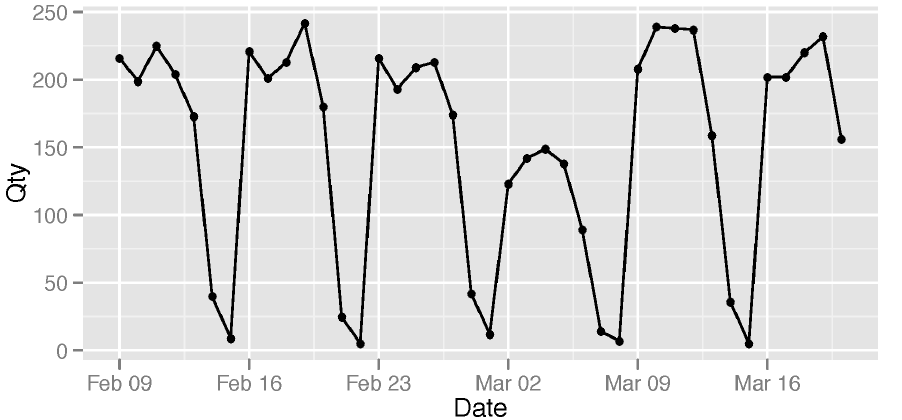
Figure 2. Total number of unique devices detected at one location. The data demonstrates how over a period of 4 weeks in 2009 the number of devices fluctuates on a daily pattern. The first data point in this plot is a Monday. The data also shows that weekends have distinctly less activity.